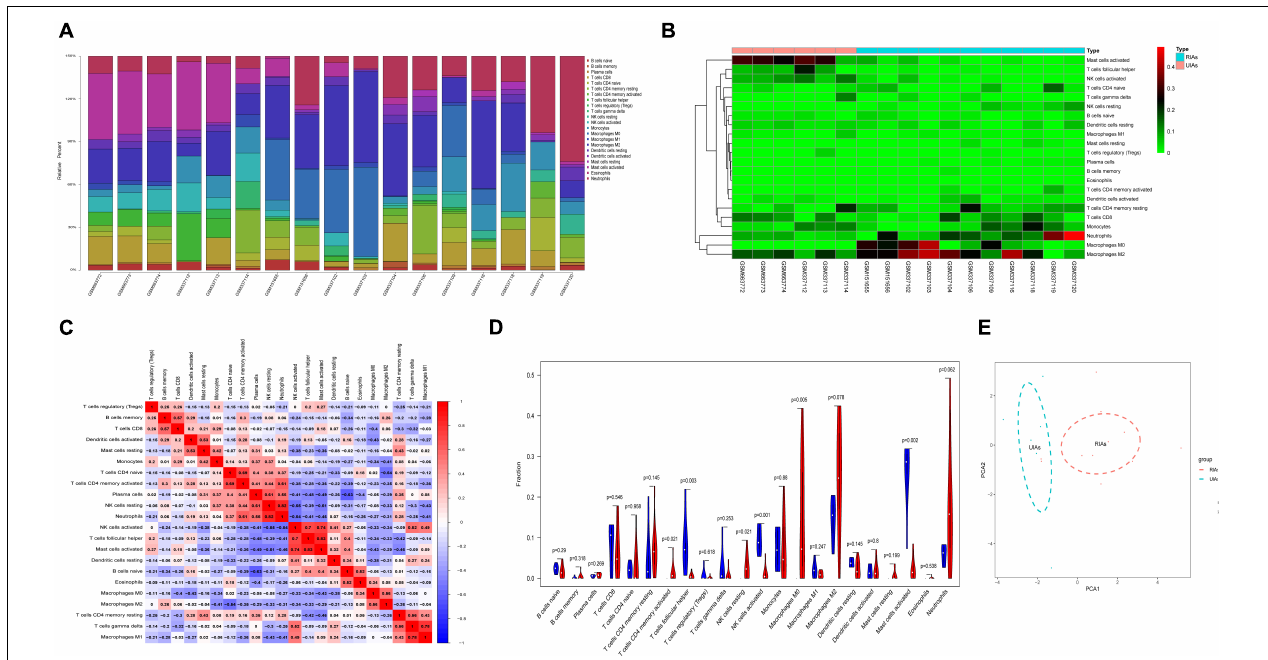
FIGURE 4 | Immune cell infiltration analysis of RIAs and UIAs. (A) Histogram of the immune cell composition in different GSMs. (B) Heatmap of the immune cell content in different samples. (C) A correlation heatmap was generated to show the correlation of immune cells. (D) A violin map was graphed to show the difference of immune cells between the RIA group and UIA group. The blue column represents UIAs, and the red column represents RIAs. (E) PCA for immune cell infiltration between RIAs and UIAs. The blue circle represents UIAs, and the red circle represents RIAs. PCA, principal component